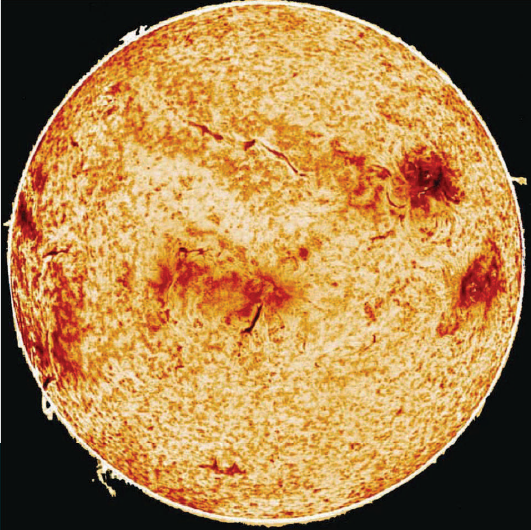
Figure 11: A full disk spectroheliogram in He i 1083 nm from the NSO/VSM instrument; solar north is up. The image shows polar coronal holes as regions of less absorption, and a low latitude coronal hole in the northern hemisphere. Dark absorption accompanies active regions, and the quiet Sun shows less absorption, but reveals the internetwork pattern. Limb prominences and limb emission are seen as bright regions off the solar limb, and a dark filament is visible on the disk in the northern hemisphere. Credits: